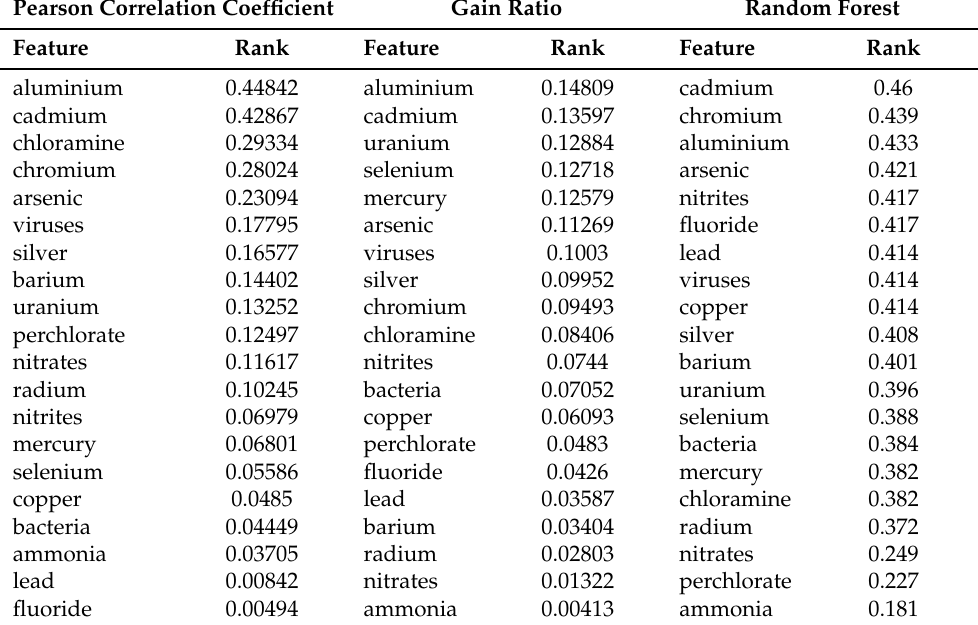
Table 2. Measure of Features’ Importance with Three Different Methods: Correlation Coefficient, Gain Ratio and Random